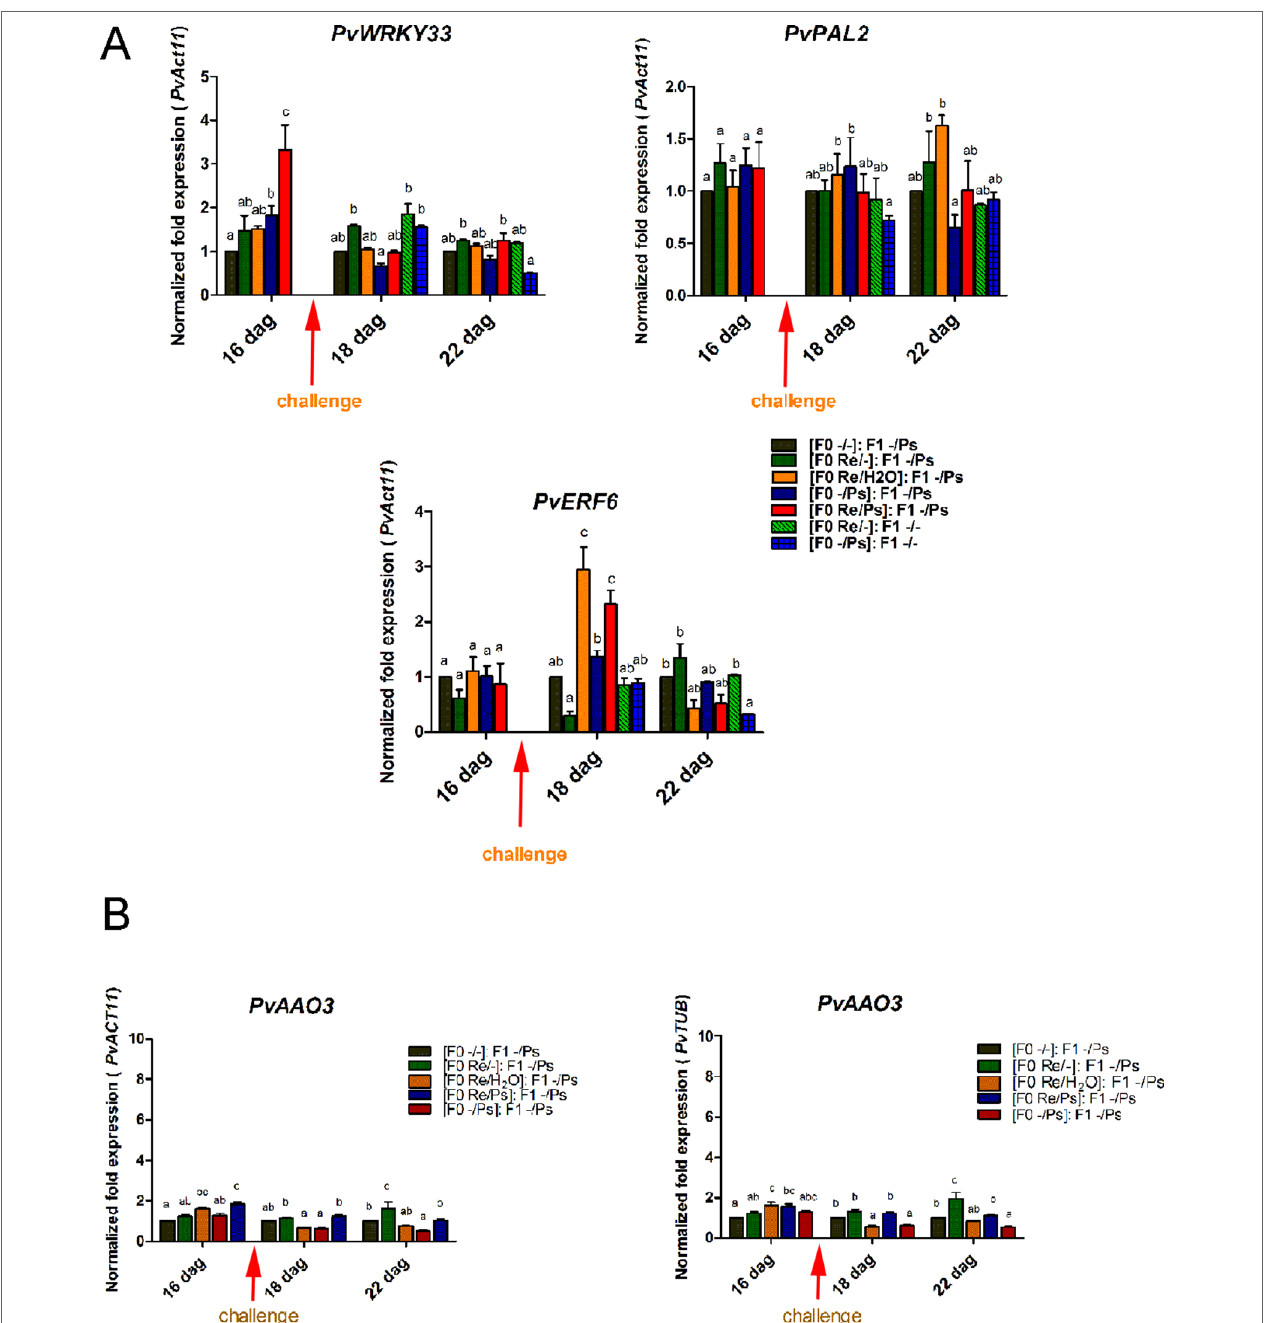
FIGURE 12 | Transgenerational transcript levels of common bean genes. (A) Transcript levels of genes involved in plant defense. (A) PvWRKY33 ; (B) PvPAL2 ; (C) PvERF6 . F0 plants were self-pollinated and grown to seed set to generate the F1 progeny. Seeds from the F1 progenies were germinated and exposed to the pathogen only, without rhizobacteria treatment. Samples were obtained at 16, 18, and 22 dag. Data were normalized to the actin11 ( PvActin11 ) and tubulin ( PvTUB , see Figure SF4) reference genes. (B) Transcript levels of the PvAAO3 gene involved in ABA synthesis. Data were normalized to the actin11 ( PvActin11 ) and tubulin ( PvTUB ) reference genes. Data are mean ± SD from three independent experiments (n = 3). Statistical significance was determined using two-way ANOVA followed by Tukey’s multiple comparison test, p < 0.05. Dag, days after